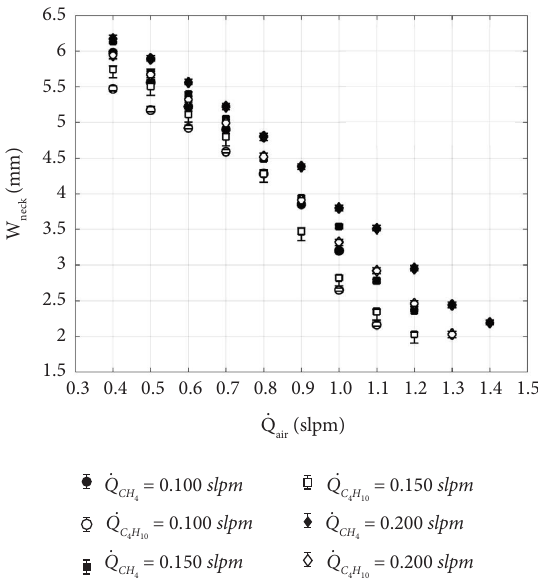
Figure 14: Variation of fame neck width with the airfow rate for methane and